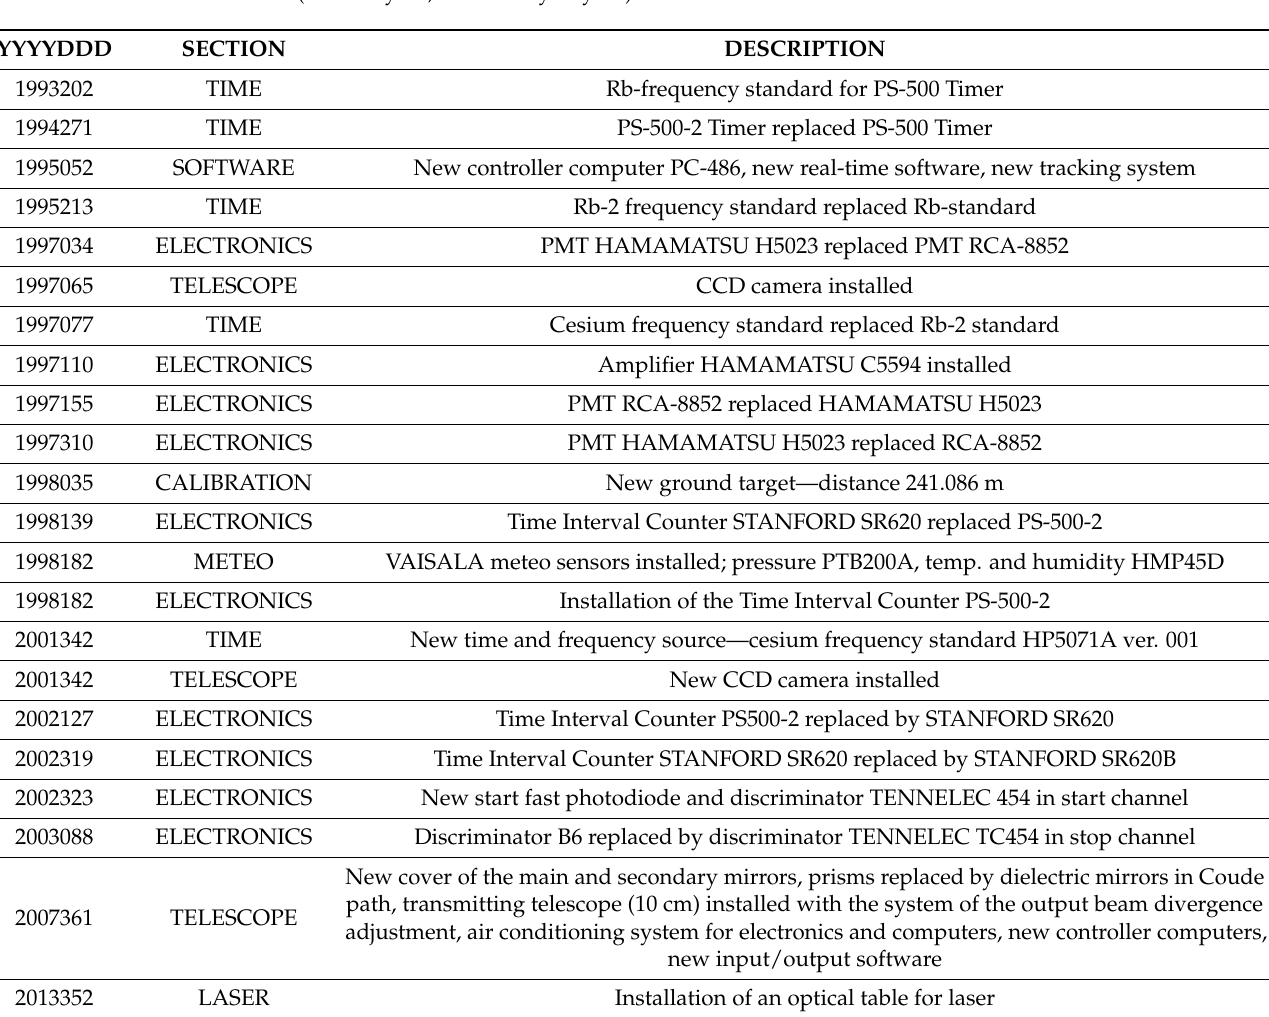
Table 1. History of the most important changes in the SLR system BORL7811 in the years 1993–2019 (YYYY—year; DDD—day of